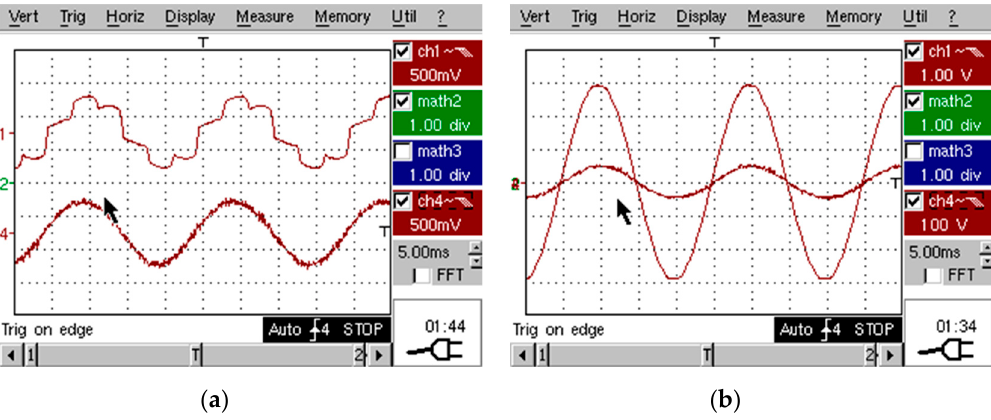
Figure 24. Oscillograms for the adaptive control at reduced load in steady state regime: ( a ) load current and supply current after compensation; ( b ) phase voltage and current after compensation.